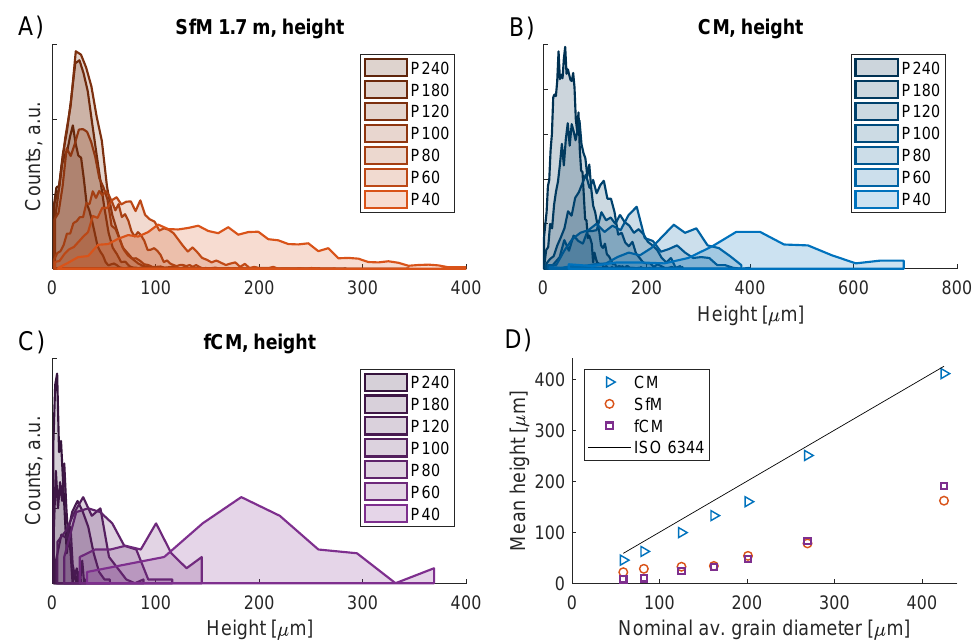
Figure 9. ( A – C ) Height distributions for SfM, CM and fCM particle analysis. ( A ) SfM, ( B ) CM, ( C ) fCM, ( D ) Mean measured height values versus the nominal grain diameter. The SfM range was 1.7 m.